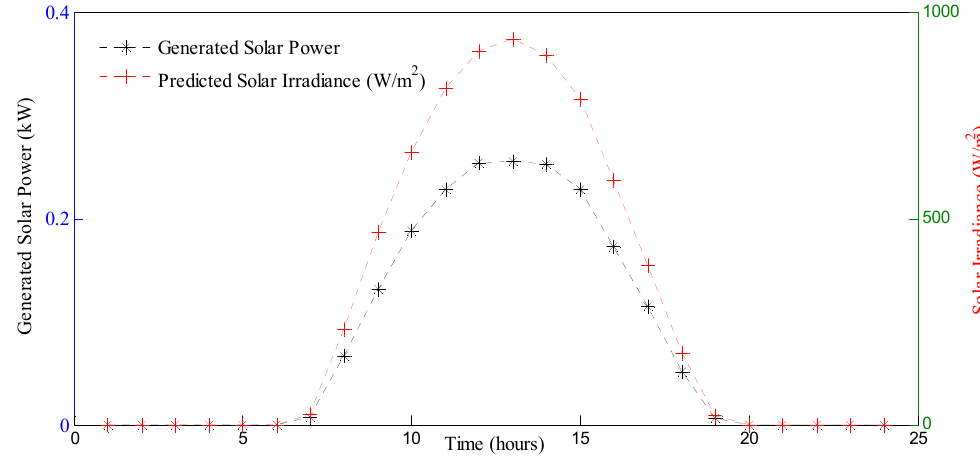
Figure 18. Predicted solar irradiance and power generated by solar panel.